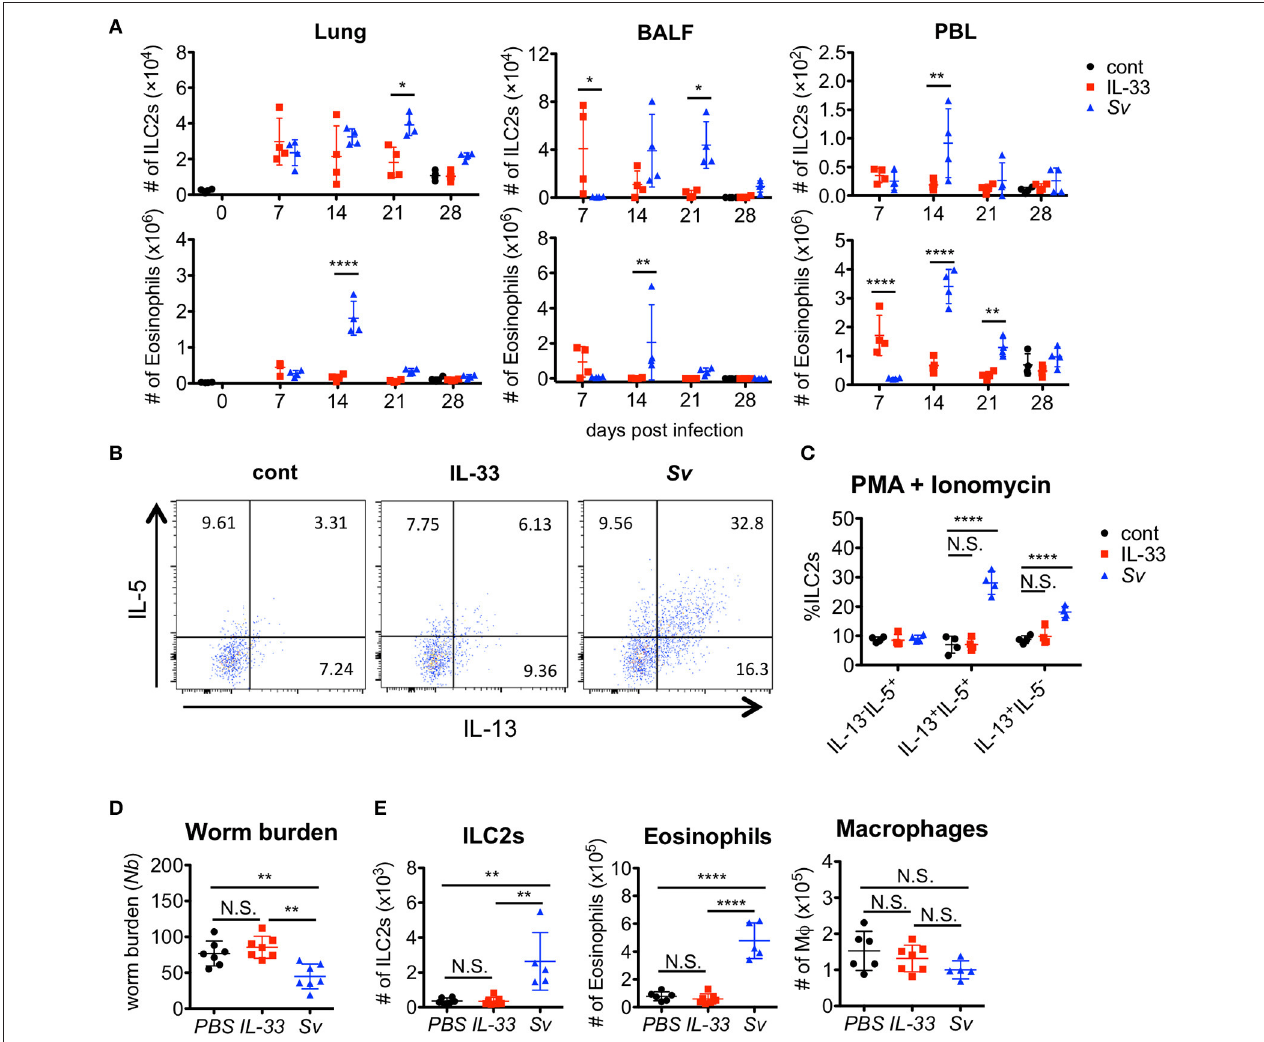
FIGURE 6 | IL-33 is not sufficient for the induction of trained ILC2s. WT C57BL/6 mice were subcutaneously inoculated with 5000 S. venezuelensis L3 at day 0 (Sv) or were intranasally administrated 100 ng of IL-33 at days 0, 1, 2, and 3 (IL-33). cont, untreated control. (A) Cell populations in the lung cells, BALF cells, and peripheral blood leukocytes (PBLs) at indicated days were analyzed by flow cytometry (SP6800) ( n = 4). Cell populations were defined as follows: Eosinophils, PI − CD45 + CD11c int CD3 − B220 − CCR3 + and ILC2s, PI − FSC lo SSC lo CD45 + Thy1.2 + Lin − Sca-1 + ST2 + . (B) Four weeks after treatment, lung cells were stimulated with PMA and ionomycin for 3h in the presence of brefeldin A. Intracellular levels of IL-5 and IL-13 in ILC2s were analyzed by flow cytometry (SP6800) as in Figure S8 . (C) The proportions of IL-5 + IL-13 − , IL-5 + IL-13 + , and IL-5 − IL-13 + cells within the population of ILC2s ( n = 4). (D,E) Mice were infected with N. brasiliensis 4 weeks after S. venezuelensis infection or IL-33 treatment. Control mice were treated with PBS (PBS) instead of IL-33. Five days after N. brasiliensis infection, (D) the numbers of worms in the intestine were counted ( n = 7). (E) The numbers of ILC2s, eosinophils, and macrophages ( n = 5–7) among the BALF cells were examined. Statistical analyses were performed using a two-way ANOVA (A,C) or one-way ANOVA (D) with Bonferroni post-hoc tests. Data are representative of three independent experiments (Mean ± SD).